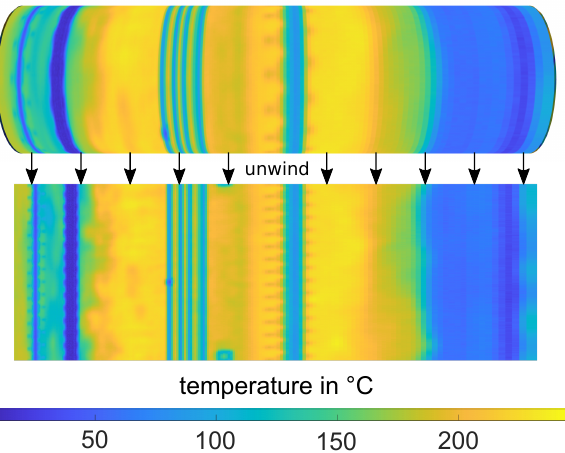
Figure 1. Unwind kiln-shell to a two-dimensional kiln-shell temperature matrix. For process documentation, the temperature matrices are saved every hour. The selected time periods contain on the one hand constant process conditions over several days and on the other hand melting processes. For further processing, the temperature matrix is divided into individual temperature zones along the longitudinal axis of the rotary kiln. Figure 2 shows the partition in different temperature zones. At date t and in zone z , the mean kiln-shell temperature is defined as KS T ( t , z )